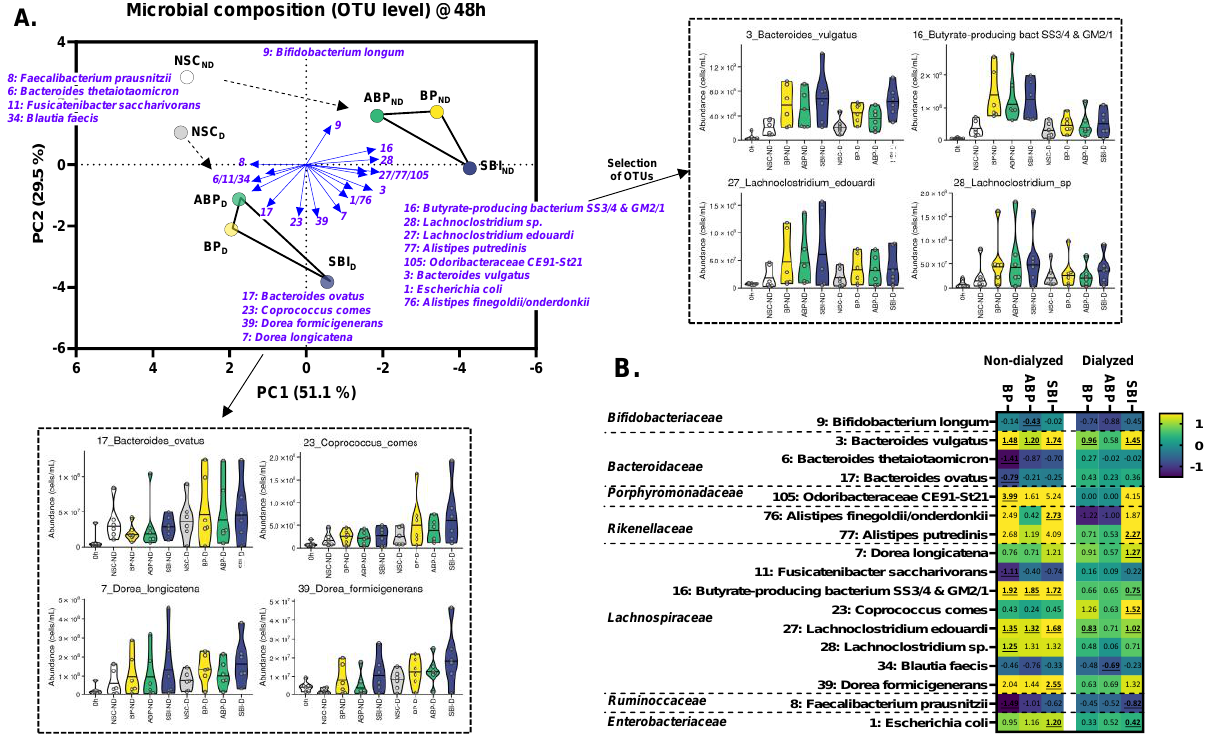
Figure 4. Three bovine plasma protein fractions (BP, ABP and SBI) stimulated specific human adult gut microbes ex vivo. ( A ) PCA summarizing the impact on the gut microbiota of three bovine plasma protein fractions (BP/ABP/SBI), dosed at an equivalent of 5 g/day, with or without prior dialysis as a simulation of small intestinal absorption, compared to the NSC, as tested via the SIFR ® technology for human adults ( n = 6). The PCA was based on the standardized abundances of significantly affected OTUs by any of the treatments (FDR = 0.20) as quantified via 16S rRNA gene sequencing combined with flow cytometry (cells/mL), at 48 h after initiation of colonic incubation. The different OTUs that underly this clustering are shown by the blue arrows. In the dotted frames, a detailed representation of the OTUs that significantly increased or decreased upon treatment with the test products is shown. ( B ) Heatmap demonstrating the impact of the bovine plasma protein fractions on OTUs that were significantly affected by any of the treatments (FDR = 0.20), expressed as log 2 (treatment/NSC), averaged over six human adults at 48 h. Significant differences compared to the NSC are indicated by bold and underlining. BP = bovine plasma, ABP = albumin-enriched bovine plasma, SBI = serum-derived bovine immunoglobulin, PCA = principal component analysis, SIFR = systemic intestinal fermentation research, NSC = no substrate control, and OTU = operational taxonomic unit.